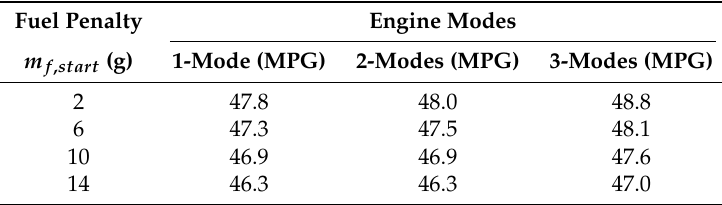
Table 4. RCCI engine fuel economy values in the SHEV architecture as a function of engine start-up fuel penalty and number of operating modes utilized in the engine (EMC: DP).